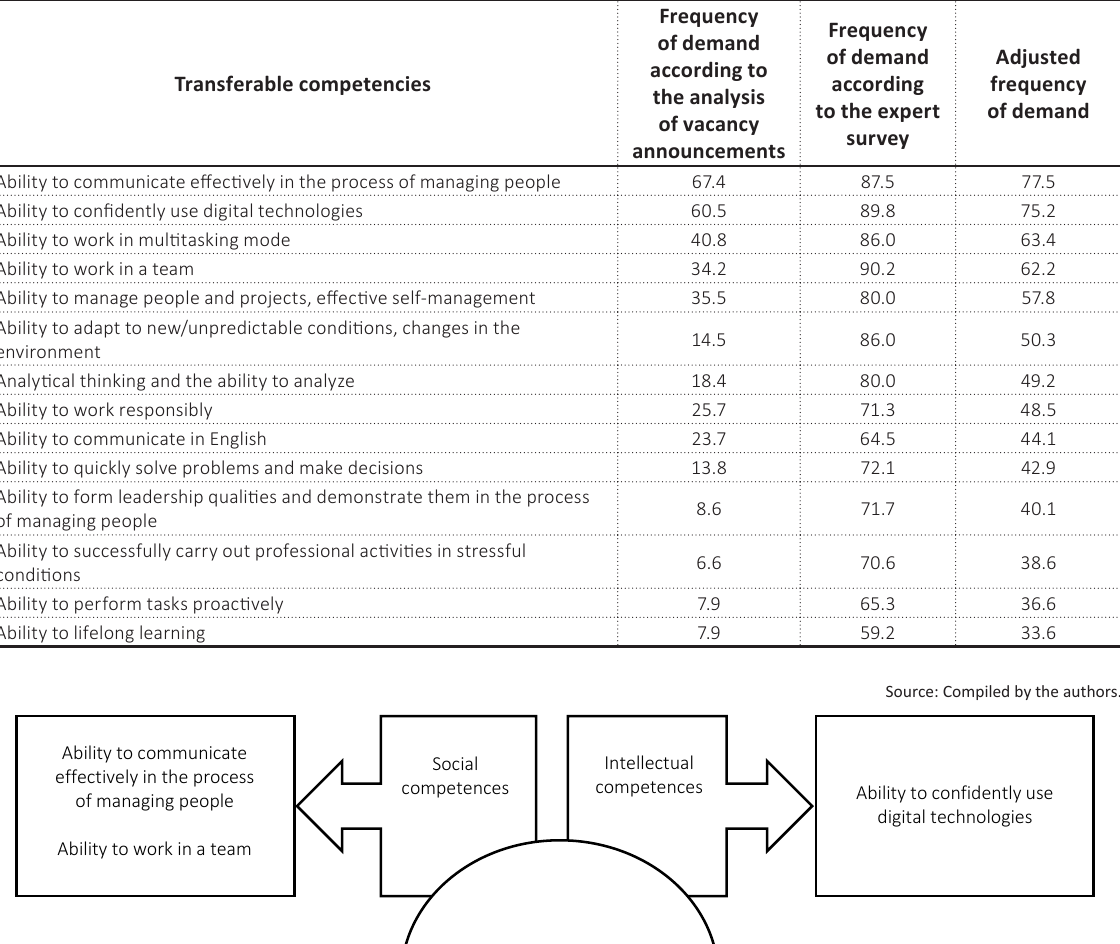
Model of transferable competencies of